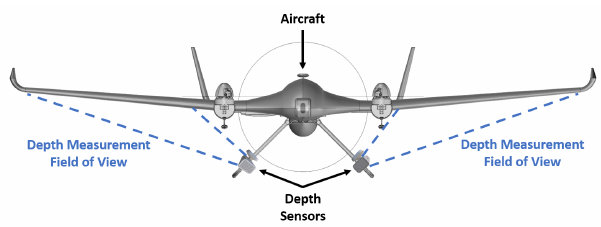
Figure 6. Possible installation locations of depth sensors on large